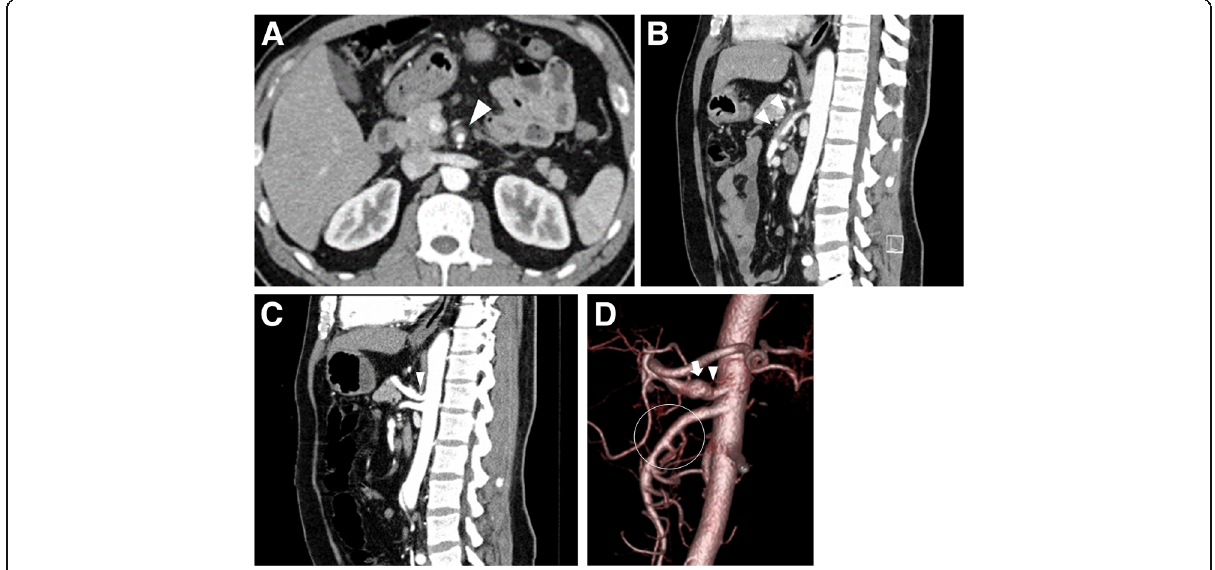
Fig. 1 a , b Superior mesenteric artery dissection with the thrombosed false lumen is shown by arrow heads on an axial view ( a ) and a sagittal view ( b ) of contrast-enhanced CT. c Sagittal view of enhanced CT showing extrinsic compression of the root of celiac axis by the MAL (arrowhead). d 3D reconstruction of abdominal aortic angiotomography showing severe stenosis of the proximal segment of the celiac axis caused by extrinsic compression of the median arcuate ligament (arrow head) and poststenotic dilatation (arrow), and narrow true lumen of superior mesenteric artery(circle) from isolated dissection with a thrombosed false